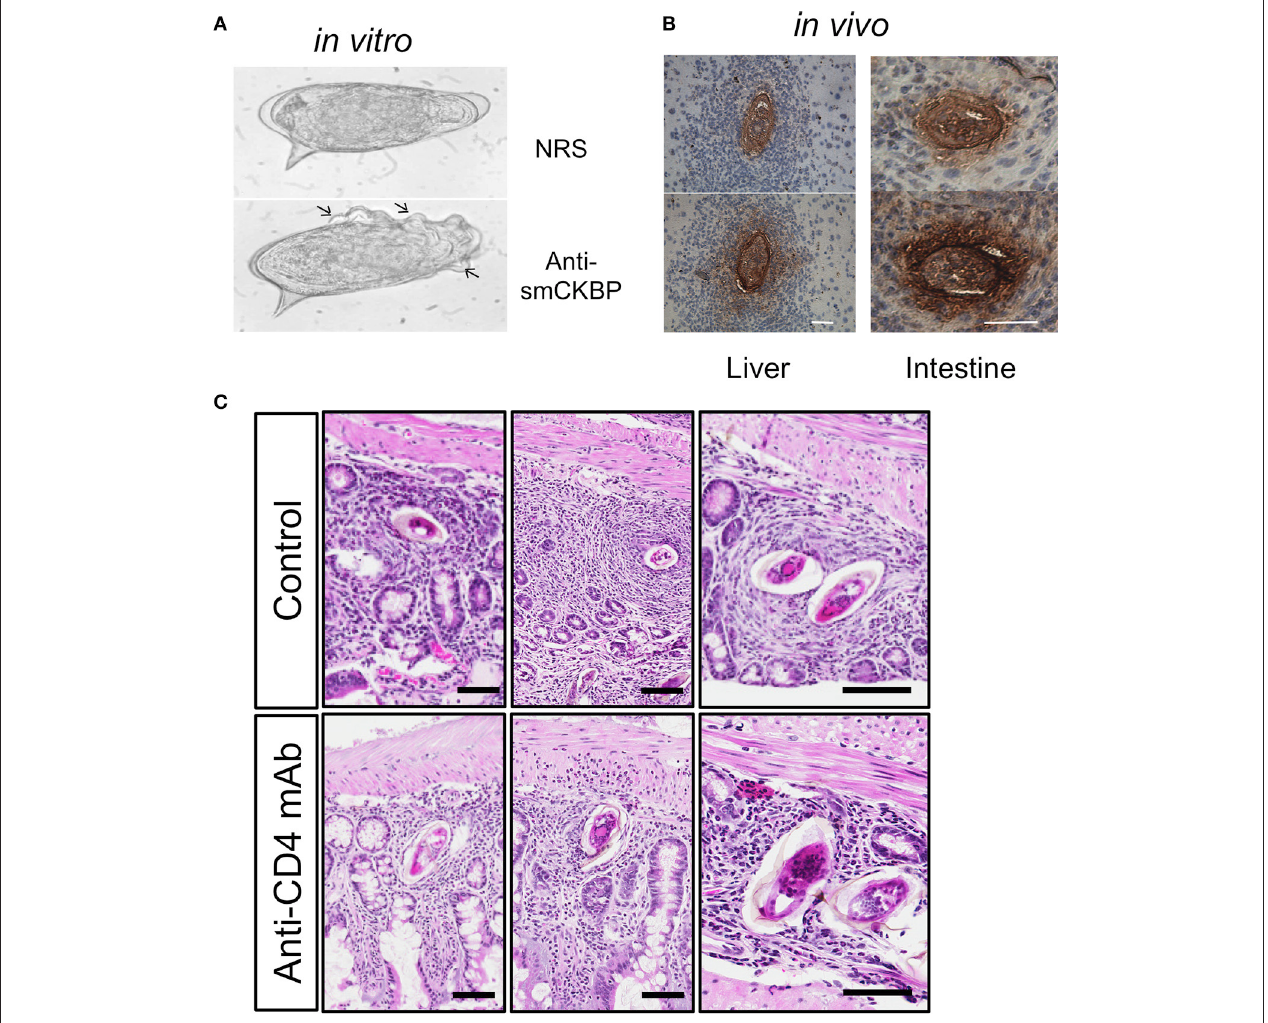
FIGURE 2 | Release of smCKBP from S.mansoni live eggs under in vitro conditions and detection in vivo adjacent to eggs within granulomas in the liver and intestine of infected mice. (A) Live eggs were cultured in vitro with anti-smCKBP rabbit sera or normal rabbit sera (NRS), with SmCKBP-antibody precipitate formation (arrows) when cultured with anti-smCKBP sera. (B) Immohistochemistry detection of smCKBP (brown stain) within the granulomas surrounding eggs in liver or intestines of infected mice. Bar, 50 µ m. © 2015 Smith et al. Originally published in The Journal of Experimental Medicine . https://doi.org/10.1084/jem.20050955. (C) Smaller granulomas forming around eggs within intestines of S. mansoni -infected mice treated with anti-CD4 mAb compared to control mice, as described ( 44). H&E-stained sections. Bar, 100 µ m.